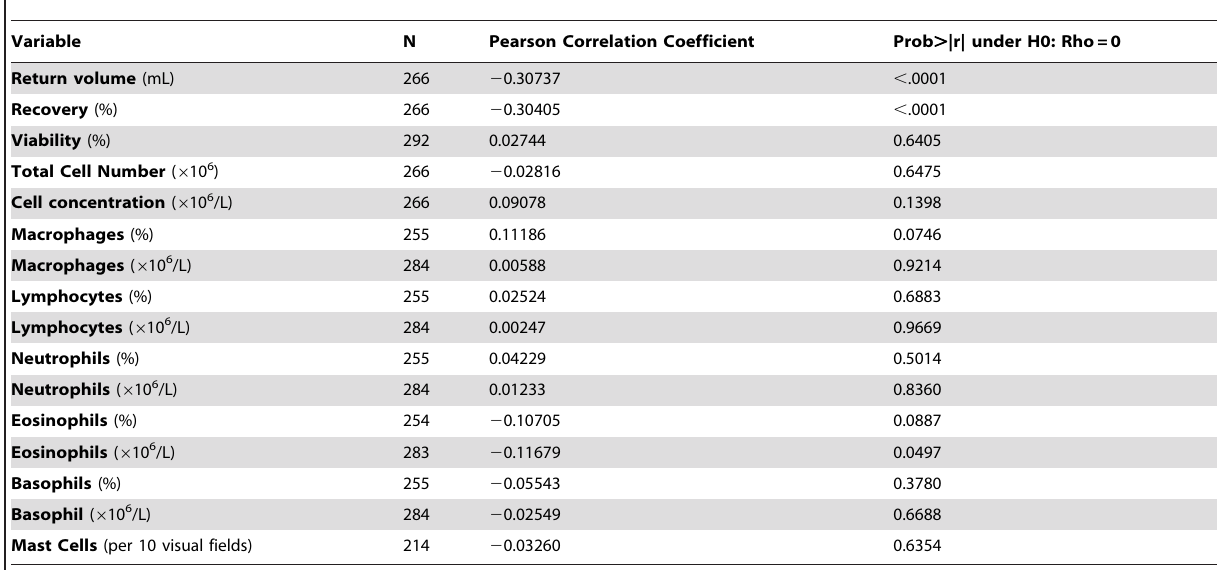
Table 3. Correlation with age for bronchoalveolar lavage fluid findings in healthy never-smoking subjects.